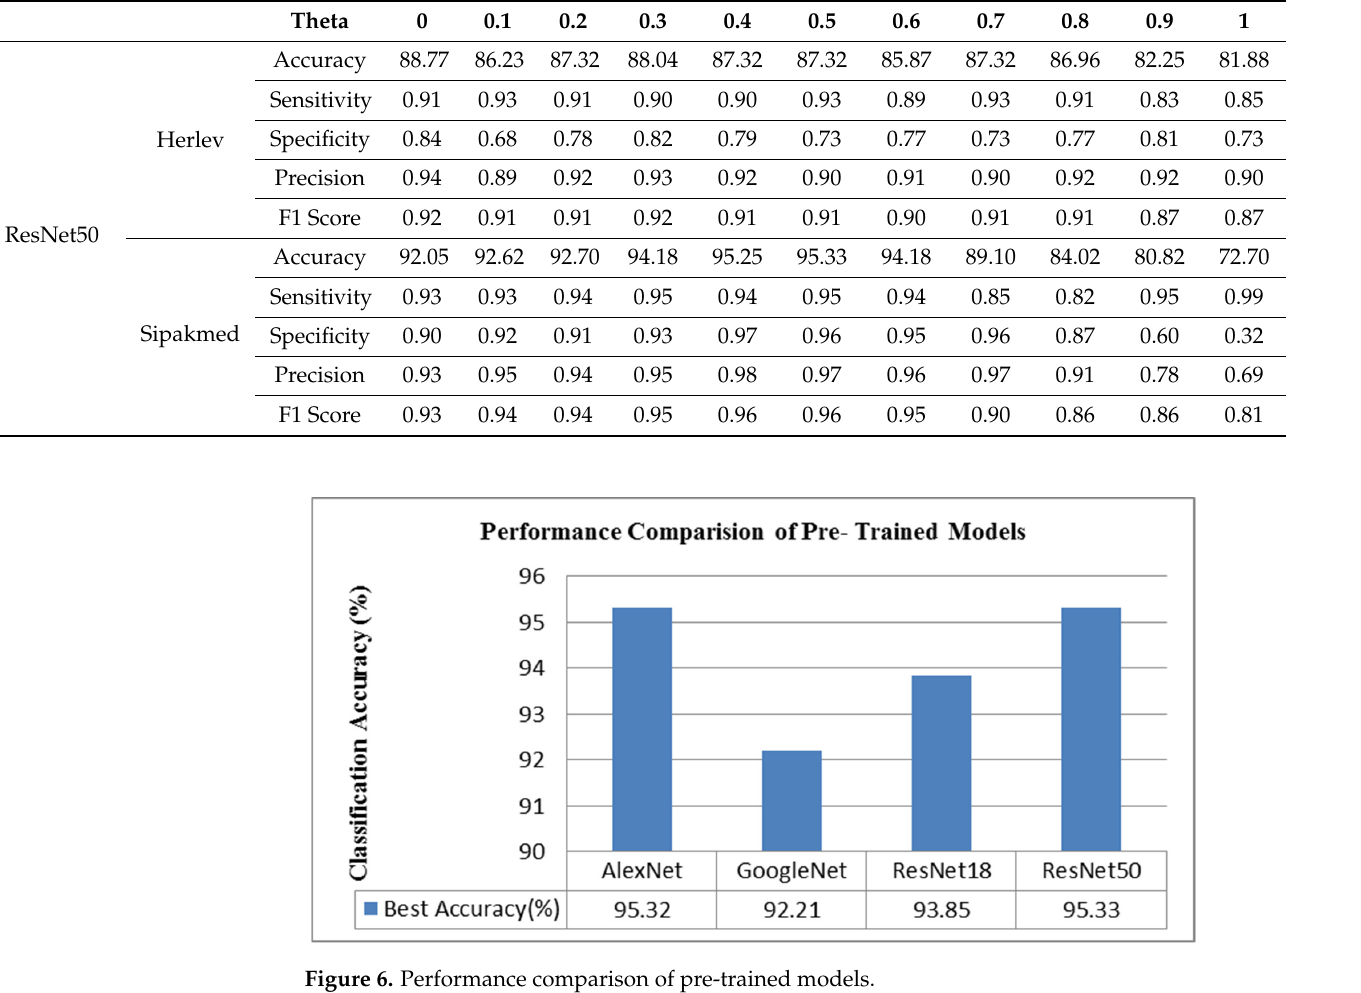
Table 13. Performance Evaluation of ResNet-50 Pre-Trained Model with Fuzzy Min–Max Neural Network.